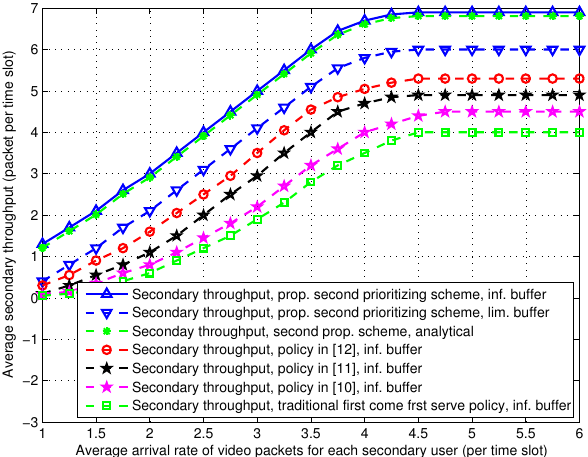
Figure 9. Comparison of the packet average waiting time in the first and second proposed